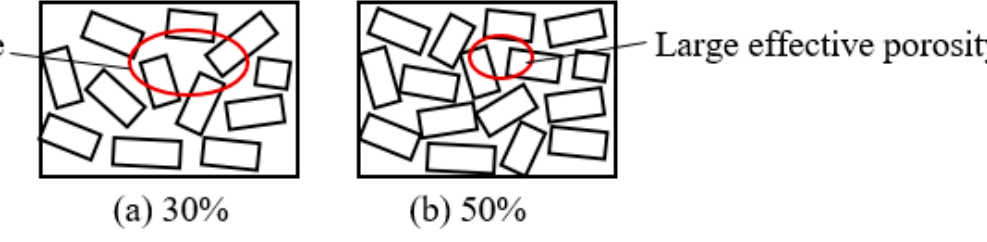
Figure 11. Curves of sound absorption coefficients for composite materials of different densities.